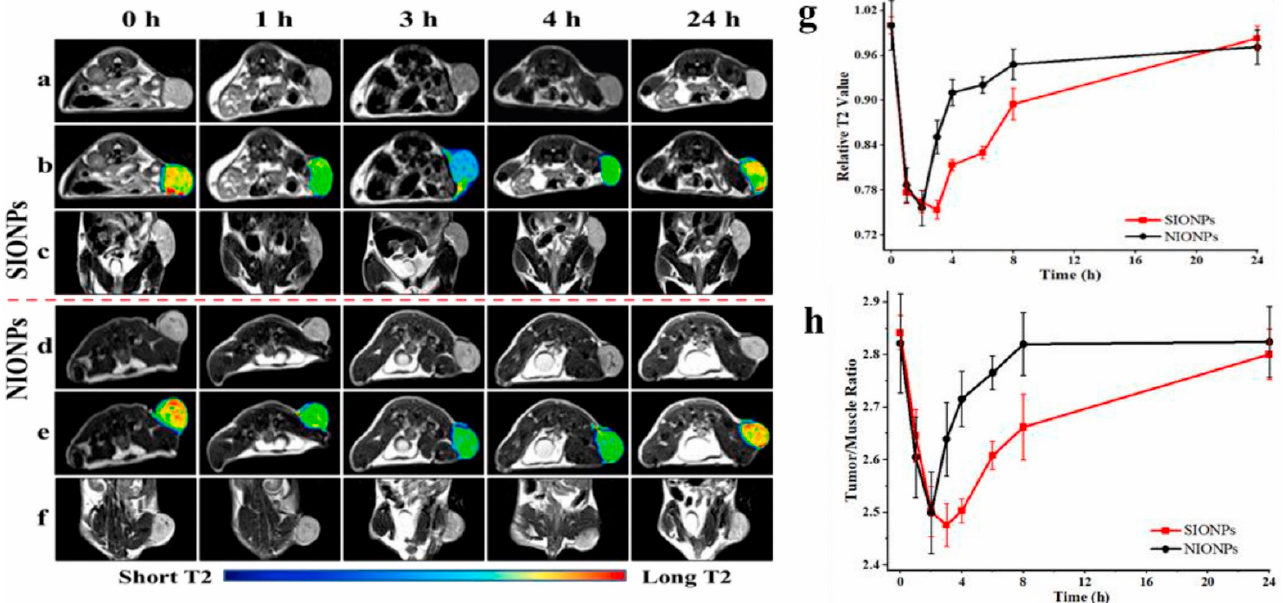
Figure 2. In vivo T 2 -weighted imaging ( a , d ), pseudo-color images ( b , e ) and coronal magnetic resonance (MR) images ( c , f ) of C6 tumor-bearing mice. ( g , h ) Quantification of signals. NIONPs: Non-sensitive superparamagnetic Fe 3 O 4 nanoparticles; SIONPs: Sensitive superparamagnetic Fe 3 O 4 nanoparticles. Reprinted (adapted) with permission from [35]—Published by Elsevier .